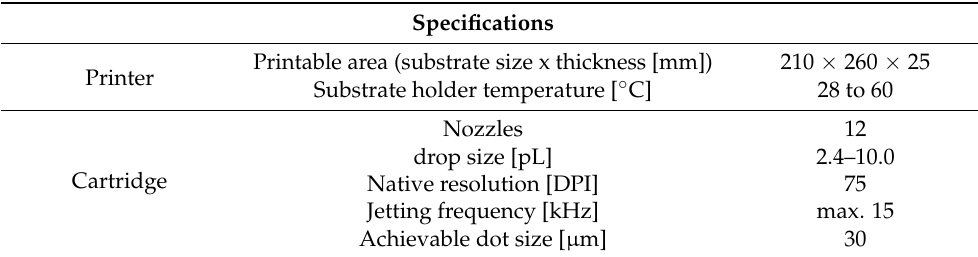
Table 2. Specification of the printer and cartridges used in this study